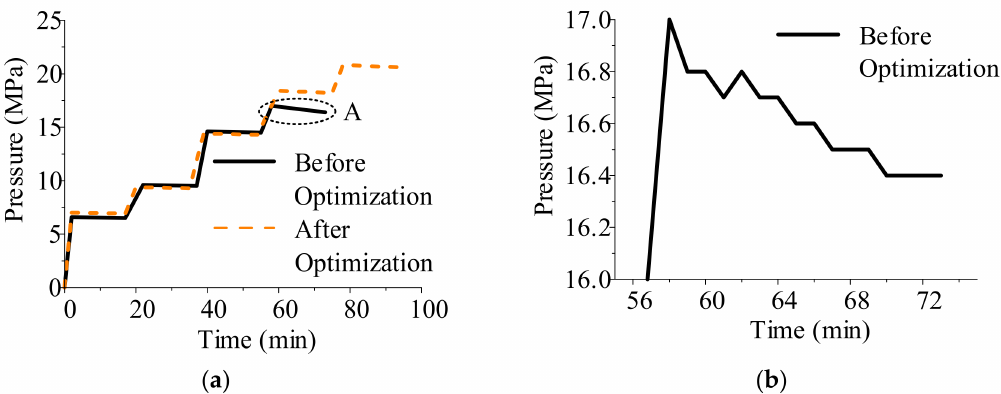
Figure 13. Curve of sealing pressure of hydrostatic pressure test. ( a ) Diagram of pressure comparison; ( b ) Diagram of partial enlargement